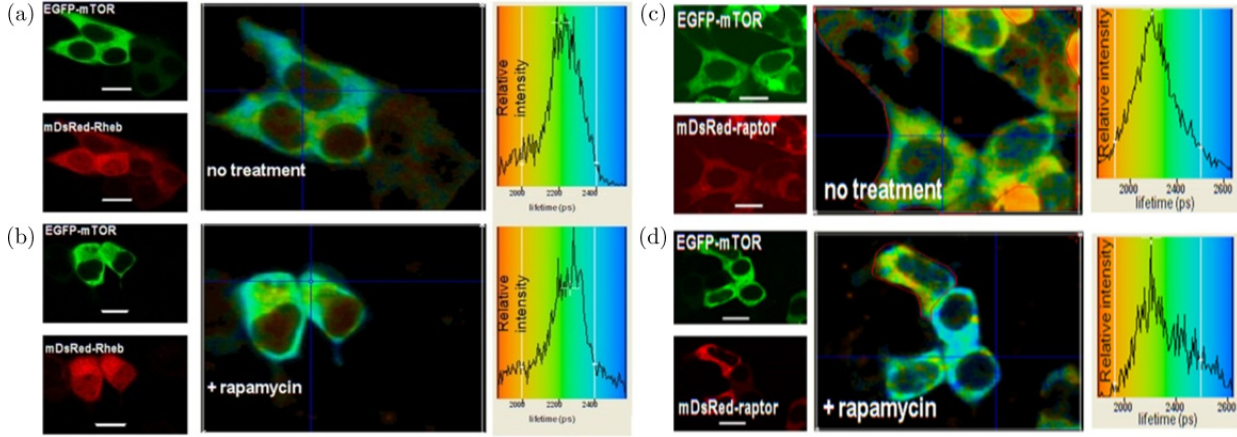
Fig. 4. (a,b) FRET – FLIM image of EGFP-mTOR and mDsRed-Rheb; (c,d) FRET – FLIM image of EGFP-mTOR and mDsRed-raptor.